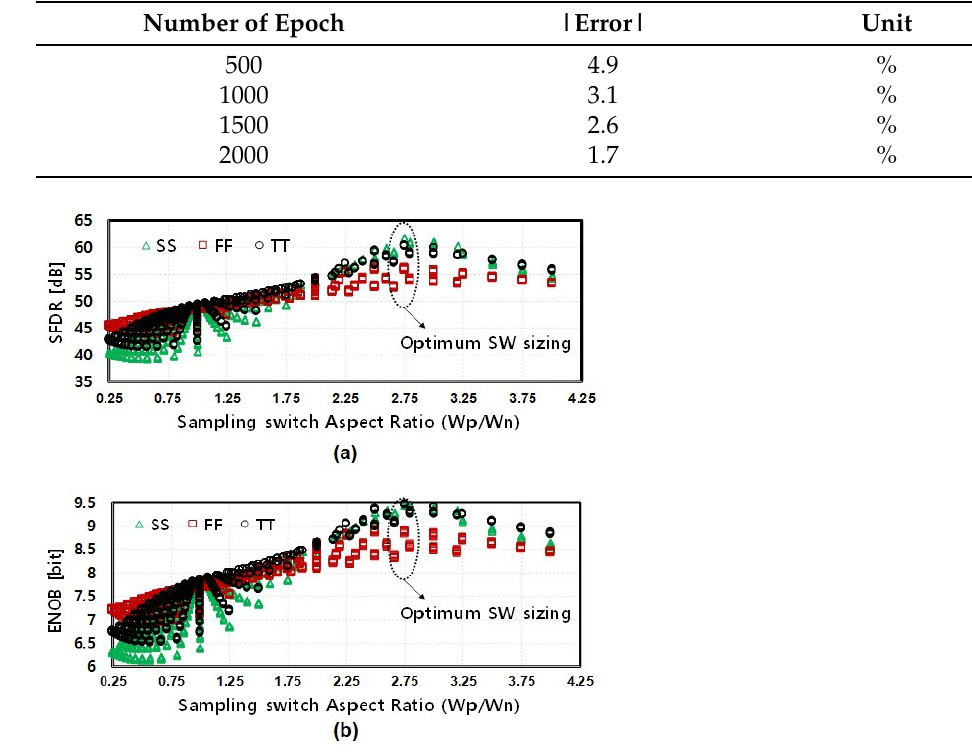
Figure 4. ( a ) T/H circuit’s linearity performance (SFDR) and ( b ) resolution (ENOB)